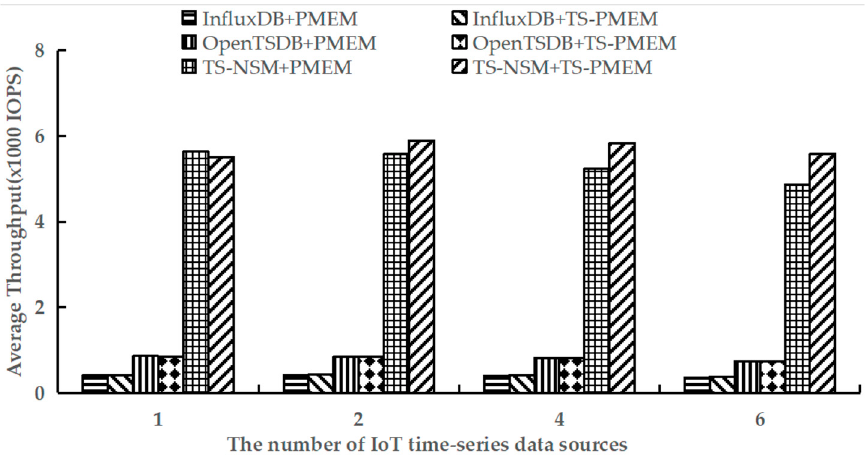
Figure 5. Average write throughput under testworkloada.